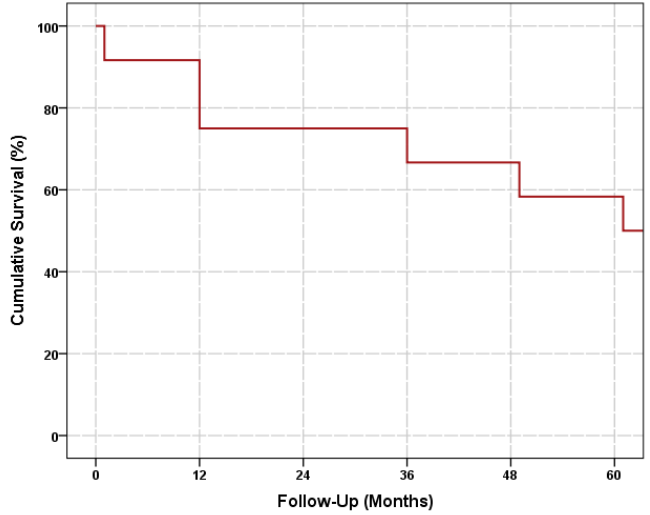
Figure 1. Kaplan–Meier survival curves showing the cumulative probability of Figure 1. Kaplan – Meier survival curves showing the cumulative probability of success. 3.3. Safety Intraoperative complications occurred in four eyes: two eyes had TDW perforations, but without iris prolapse, wherein the procedure was continued while maintaining a formed anterior chamber; two eyes had TDW perforation with iris prolapse, wherein pe- ripheral iridectomy and iris repositioning were performed without sclerotomy. The deep